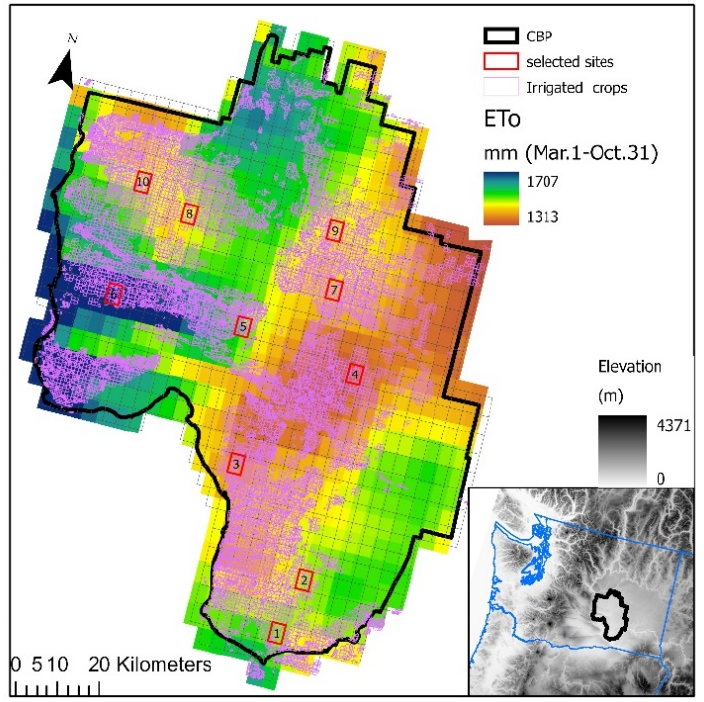
Figure 1. Selected grids and average total reference crop evapotranspiration (ETo) from 1 March to 31 October for years 1981–2009 in the Columbia Basin Project of the USA Pacific